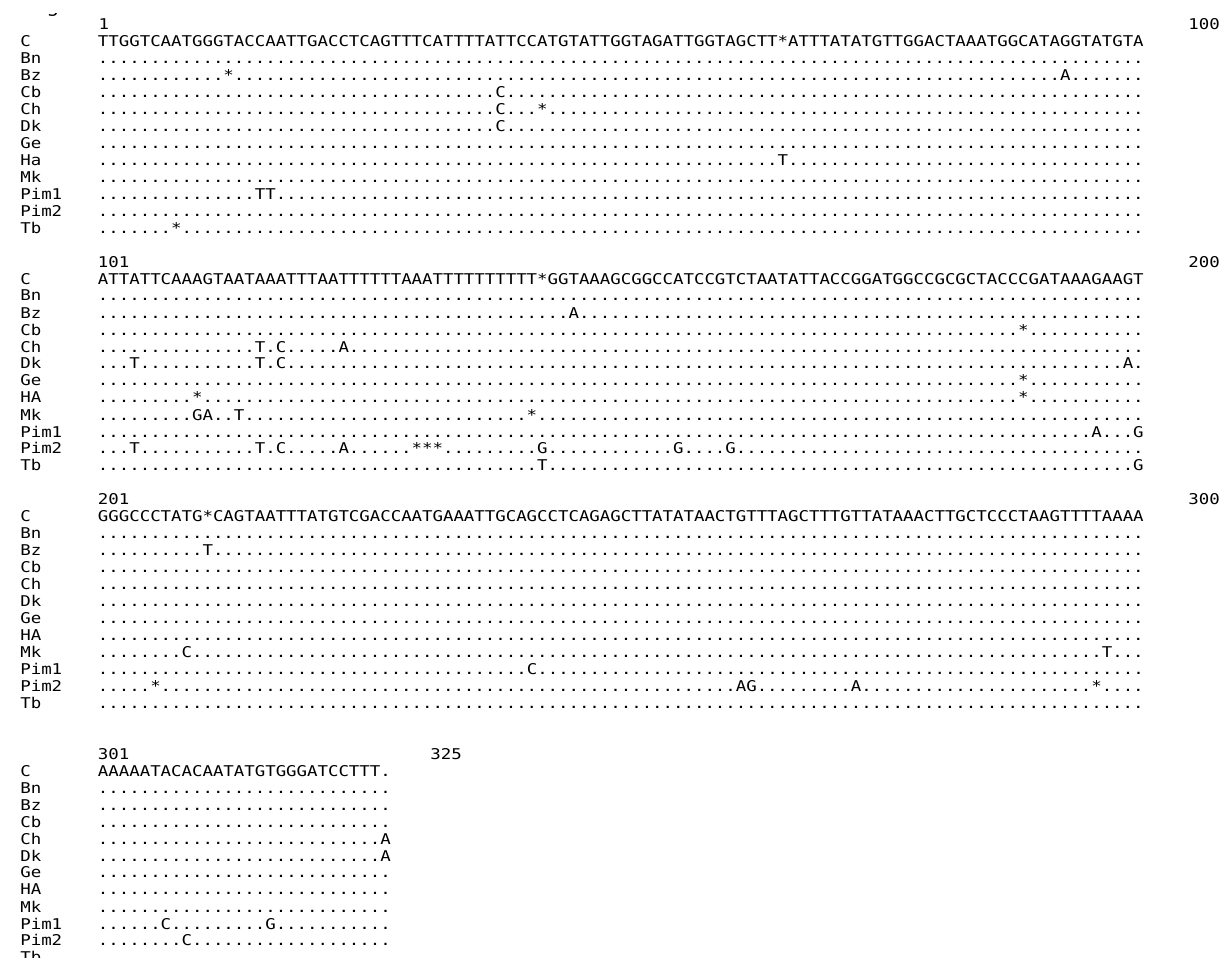
Fig. 5. Multiple alignment of IR nucleotide sequences of Tunisian TYLCV isolates. C indicates consensus sequence. Asterisks show deletions. Dots indicate nucleotides identical to the consensus. The conserved nonanucleotide mo- tif is